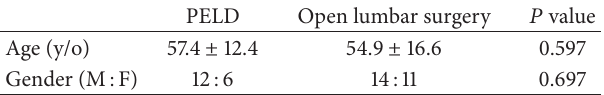
Table 1: Summary of patient demographic data for the two groups. PELD Open lumbar surgery 𝑃